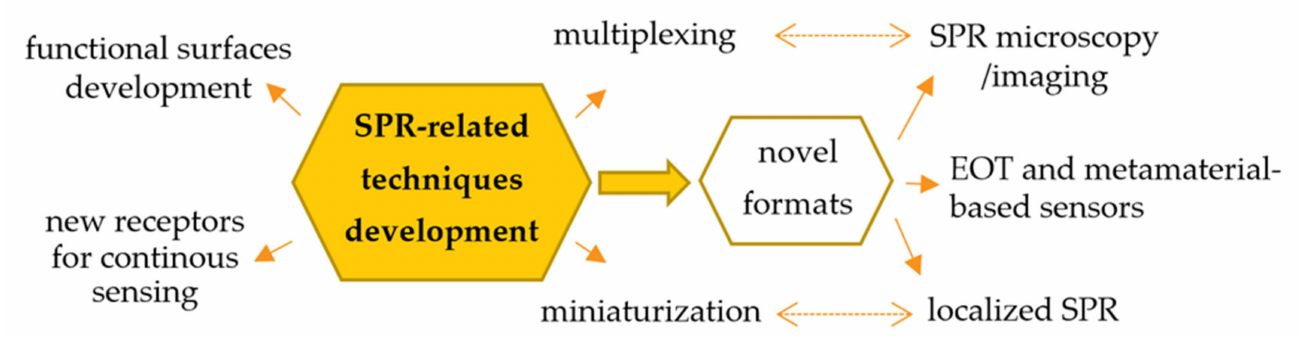
Figure 1. Current major trends in the development of plasmon-based